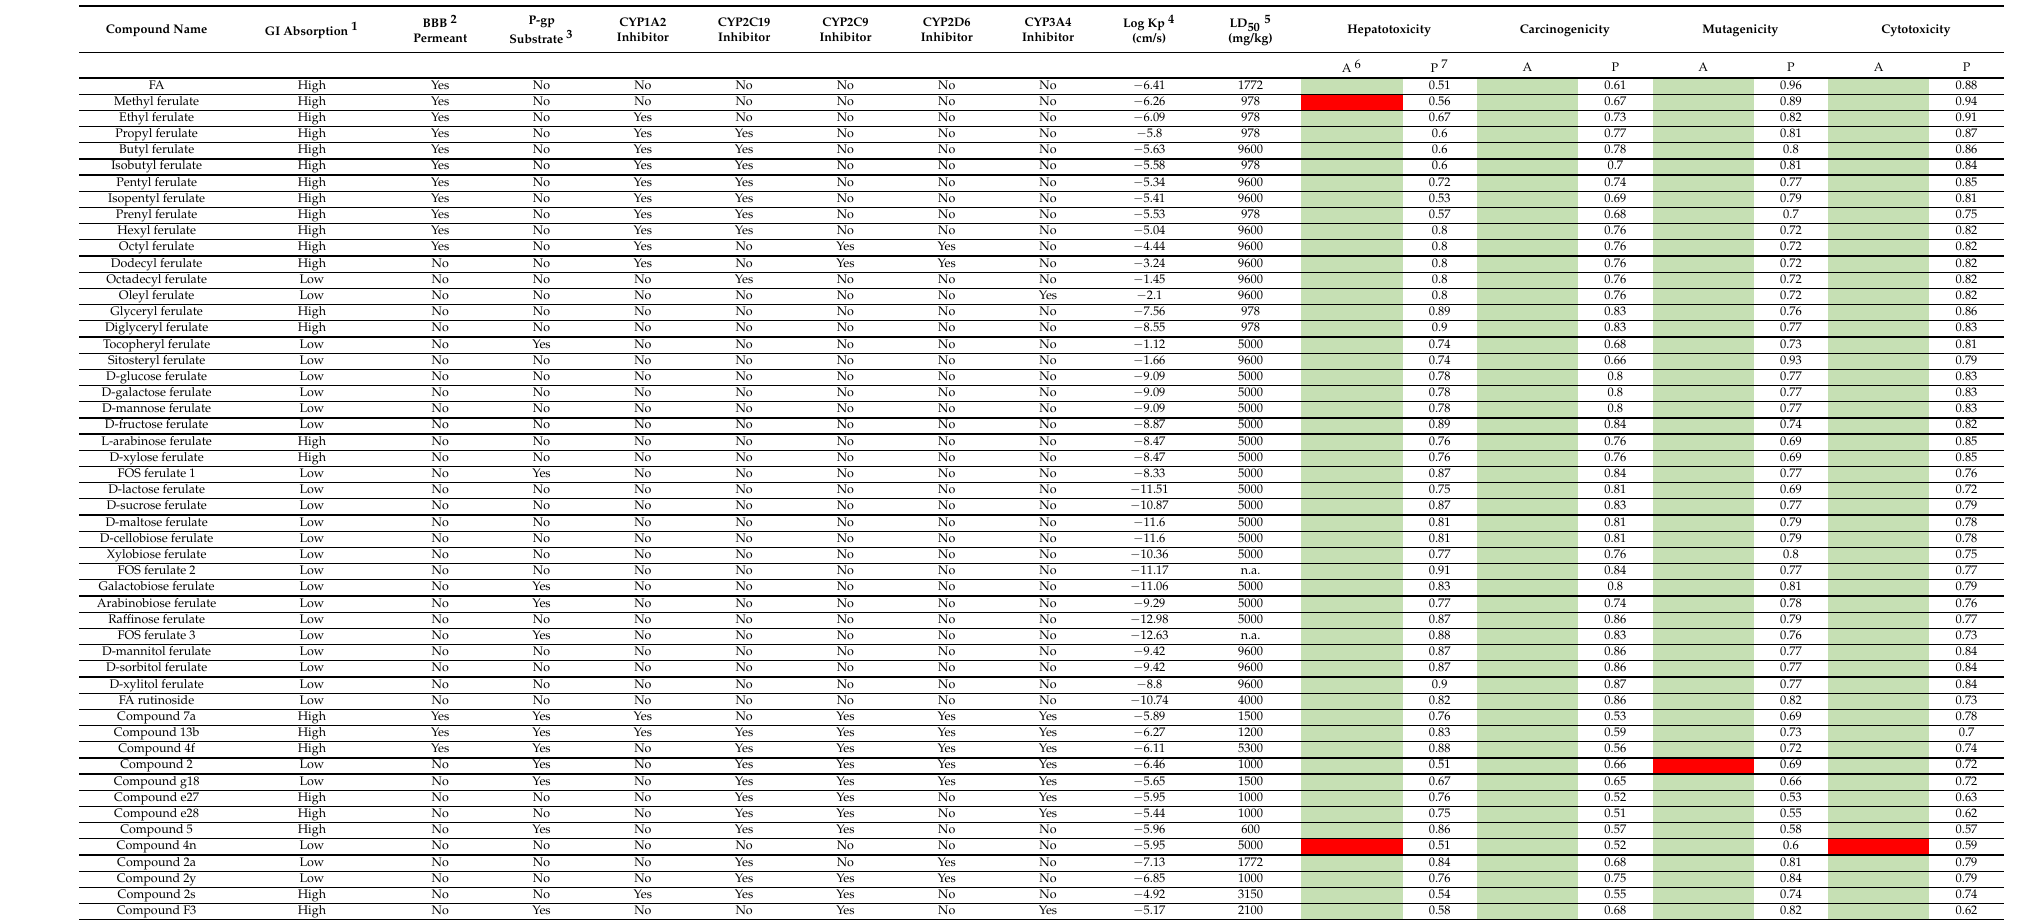
Table 6. Pharmacokinetic and toxicity predictions for FA and its selected